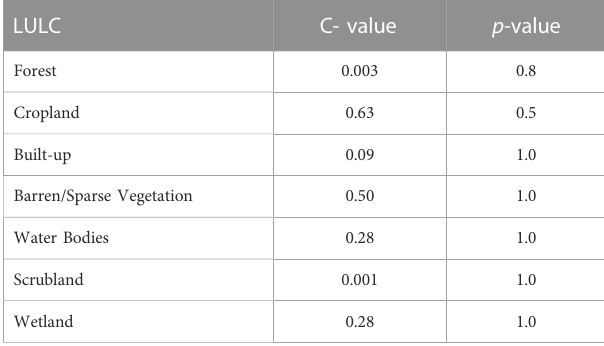
TABLE 2 C and p factors for different LULC.